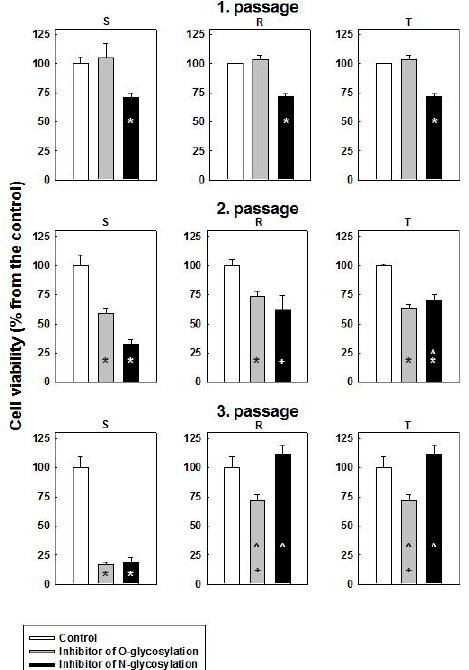
Figure 1. Cell death effects of GalNAc- α - O -benzyl (O-glycosylation inhibitor) and